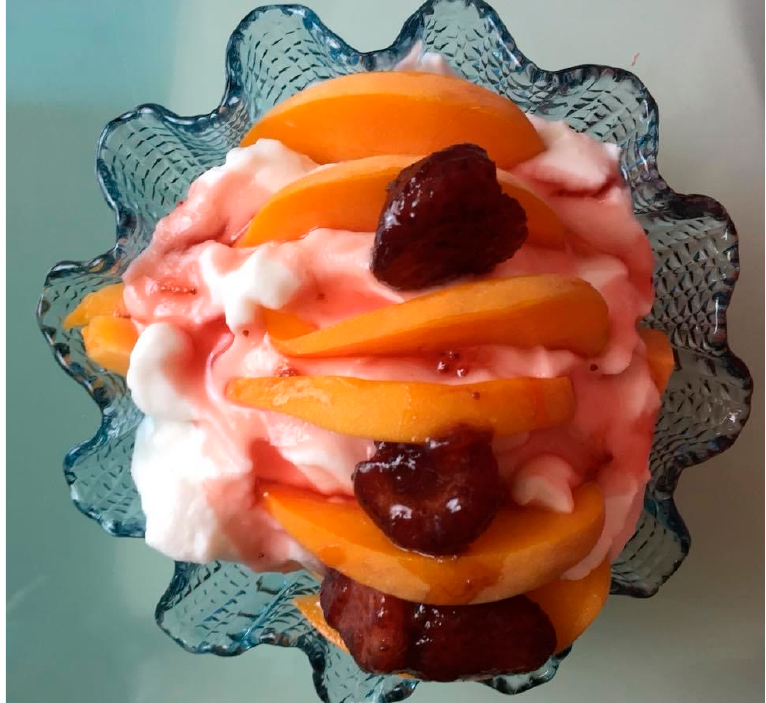
Figure 5. Hogweed gelo with percoca peach and wild strawberries in syrup. Picture and recipe by Eleonora Matarrese. The full recipe is available in the Supplementary Materials.